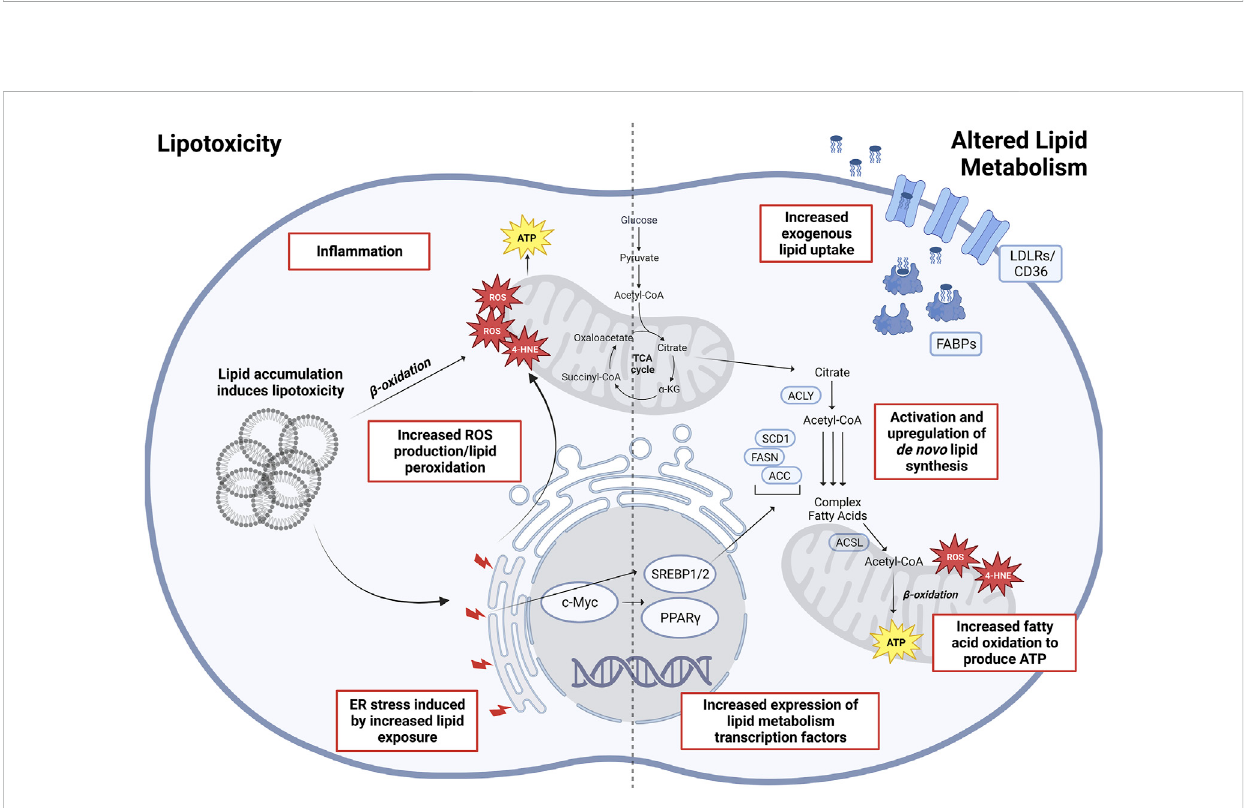
FIGURE 2 Altered lipid metabolism and lipotoxicity in oncogenesis. Depicted (Left) are various factors associated with lipid accumulation and are lipotoxicity induced, eventually increasing overall cellular stress leading to oncogenesis and malignant transformations. (Right) Main altered pathways in lipid metabolism associated with cancers. Abbreviations: ROS, reactive oxygen species; 4-HNE, 4-hydroxynonenal; SREBP1/2, sterol regulatory element – bindingproteins1/2;PPAR γ ,peroxisomeproliferator-activatedreceptorgamma;ACLY,ATP-citratelyase;SCD1,stearoyl-CoAdesaturase 1; ACSL, long-chain fatty acid – CoA ligase 1; FASN, fatty acid synthase; ACC, acetyl-CoA carboxylase; FABP, fatty acid – binding proteins; LDLR, low- density lipoprotein receptor. Created with